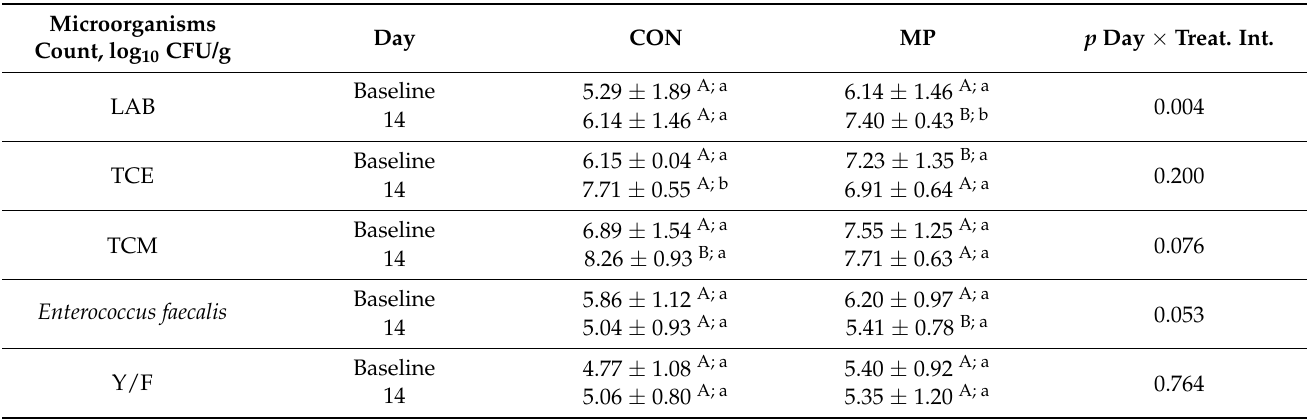
Table 2. Faecal microbiological parameters of calves fed with milk replacer only (CON group) or supplemented with fermented milk permeate (MP